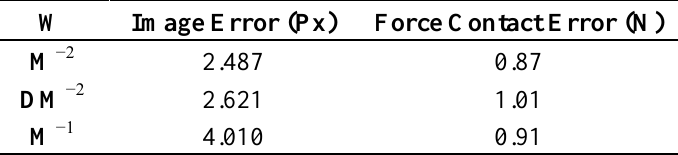
Table 1. Mean image and force contact error during the first set of